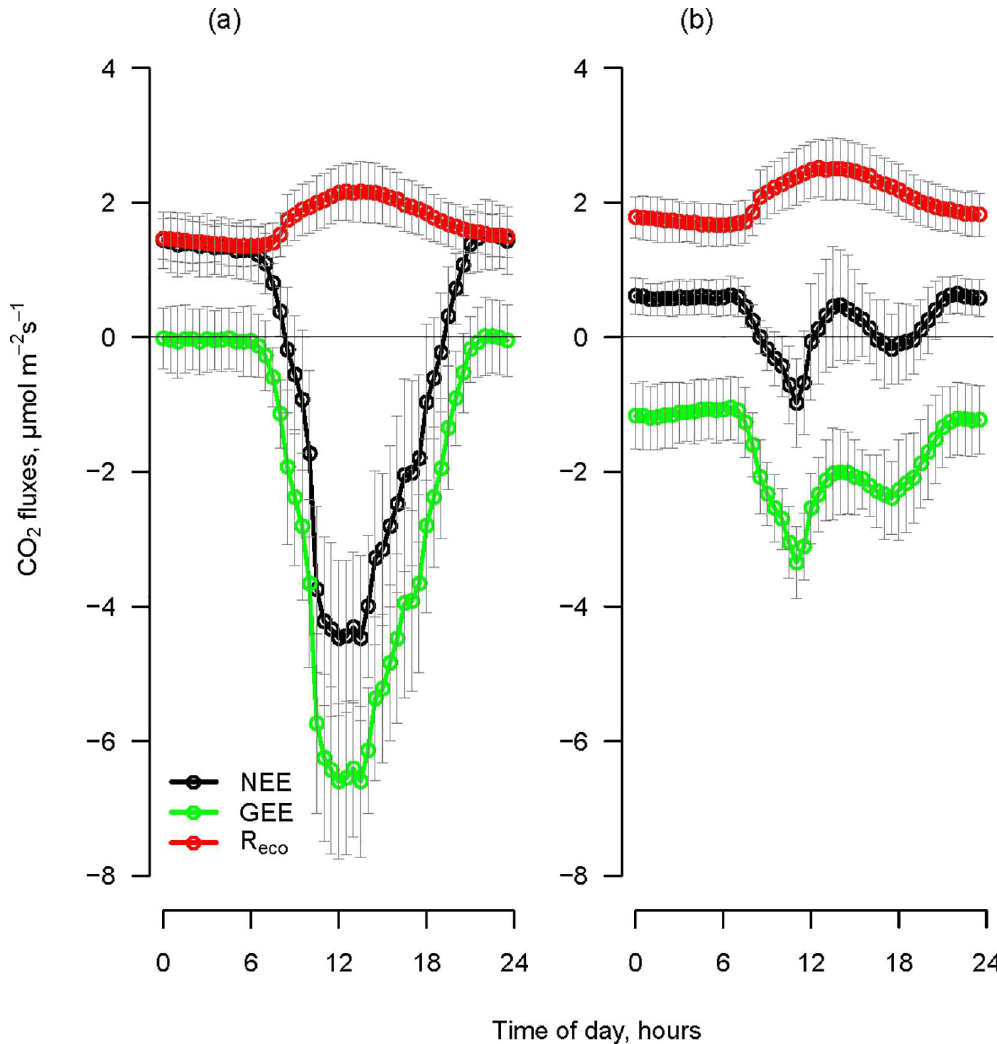
Fig 5. Daily patterns (mean ± SD) during August 2013of the net ecosystemexchange (NEE) measuredat all the plots, the modelled ecosystem respiration (R eco ) and gross ecosystemexchange (GEE) as obtained after flux partitioning for (a) Festuca and (b) Sempervivum plots. GEE, indicating gross CO 2 uptake, is representedhere as negative consistently with the other